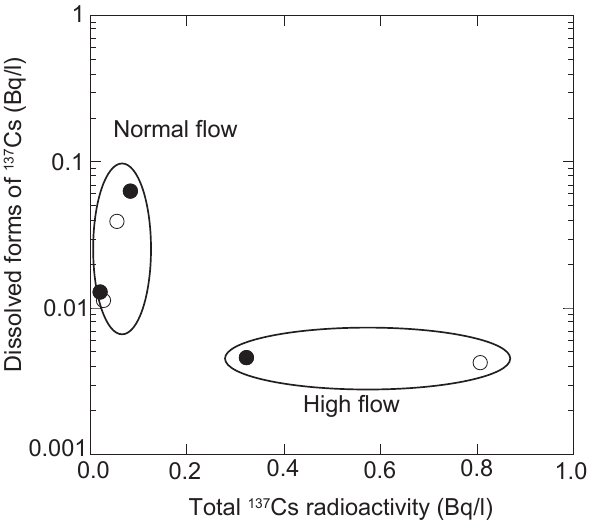
Fig. 4. Total and dissolved radioactivity of 137 Cs in river waters from the Natsui River ( ◦ ) and the Same River ( •